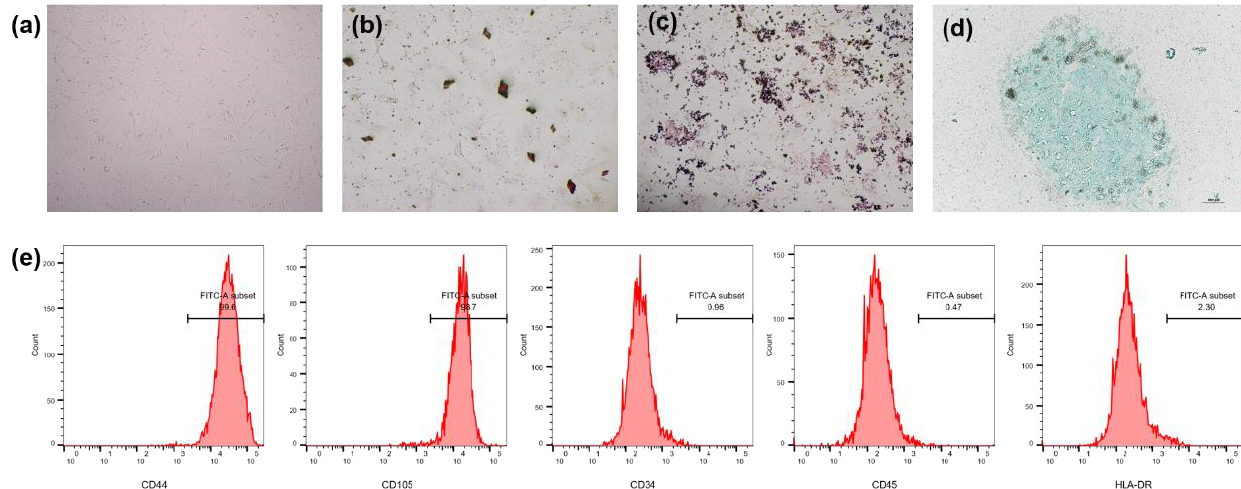
Figure 6. Identification of hMSCs. ( a ) Morphology of hMSCs in passage 5 under a microscope; ( b ) osteogenic differentiation of hMSCs stained with Alizarin Red; ( c ) adipogenic differentiation of hMSCs stained with Oil Red O; ( d ) chondrogenic differentiation of hMSCs stained with Alcian Blue; and ( e ) flow cytometry of MSC surface markers CD44 and CD105, and hematopoietic cell markers CD34, CD45 and HLA-DR of hMSCs in passage 5. Abbreviations: hMSCs, human bone marrow mesenchymal stem cells.